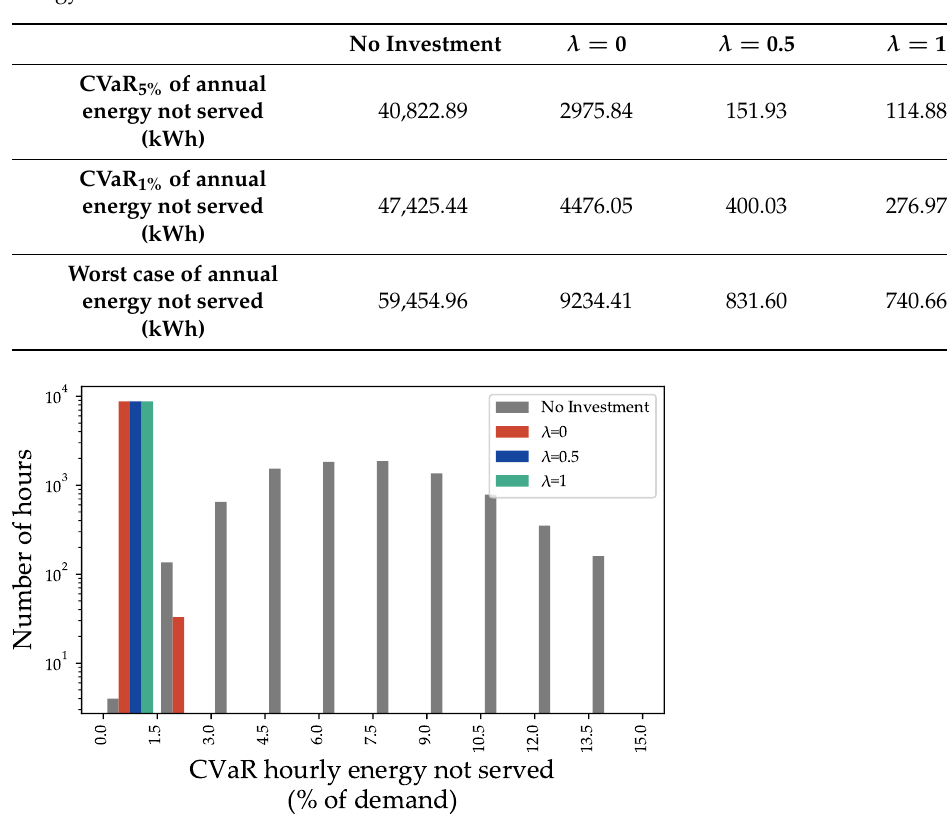
Table 3. Out-of-sample analysis—Risk aversion metrics (CVaR 5% , CVaR 1% and worst case) of annual energy not served.